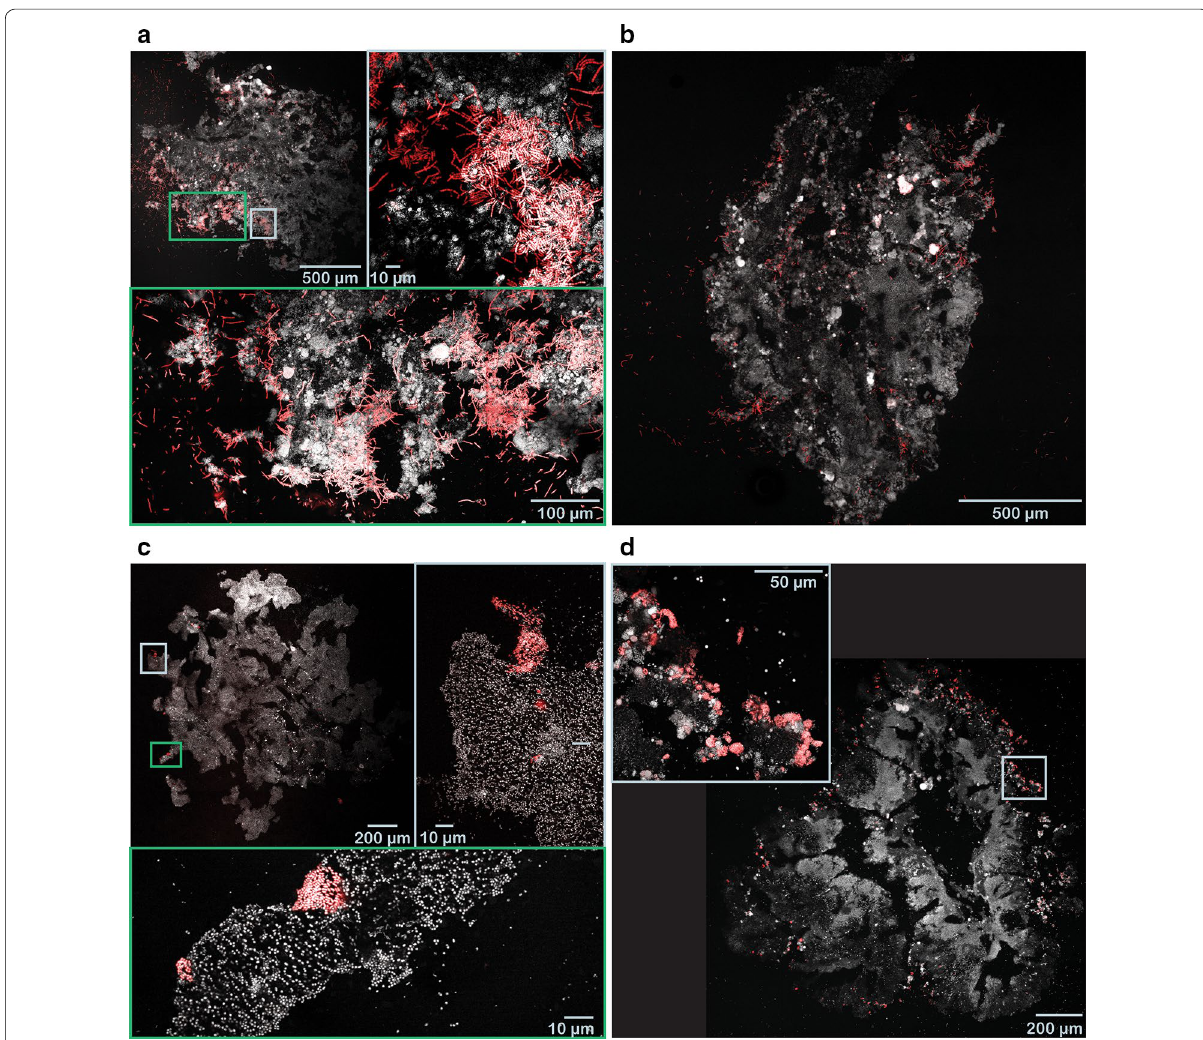
Fig. 4 FISH‑CLSM images of selected bacteria with retention ratios significantly lower than one. Cryosections of granules at and detailed sections at 400 magnification. a , b Meganema perideroedes in granules from R2; c Zoogloea spp. in granules from R2; d Zoogloea spp. × in aerobic granules from R3. Grey total cells (Syto 40); red Meganema perideroedes ( a , b ) and Zoogloea spp. ( c , d